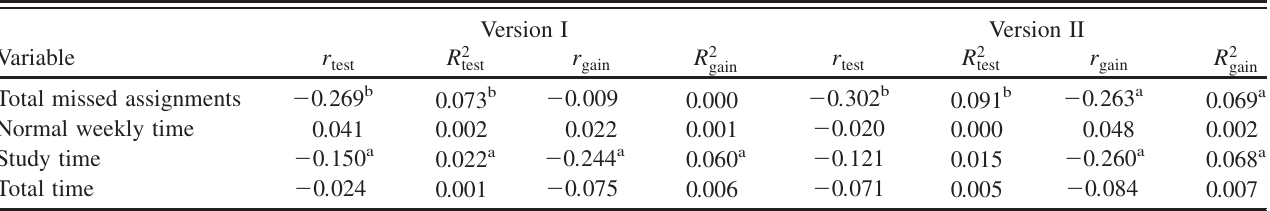
USING TIME-ON-TASK MEASUREMENTS TO . . TABLE III. Time on task. The variables r and R 2 measure the correlation and R 2 with respect to the normalized gain. For version I, N ¼ 194 students were included, and gain version II included N ¼ 166 .